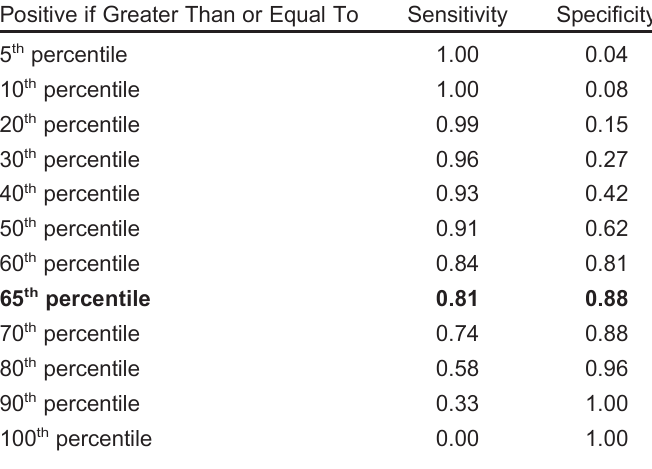
Table 3. The sensitivity and the specificity of different Resident In- Service Examination percentiles as cut-off points for predicting pass or fail on the American Osteopathic Board of Emergency Medicine Part 1 for the pooled data on the 409 subjects. The 65 th percentile (in bold) was the cut-off point, which maximized the sensitivity (0.81) and specificity (0.88).